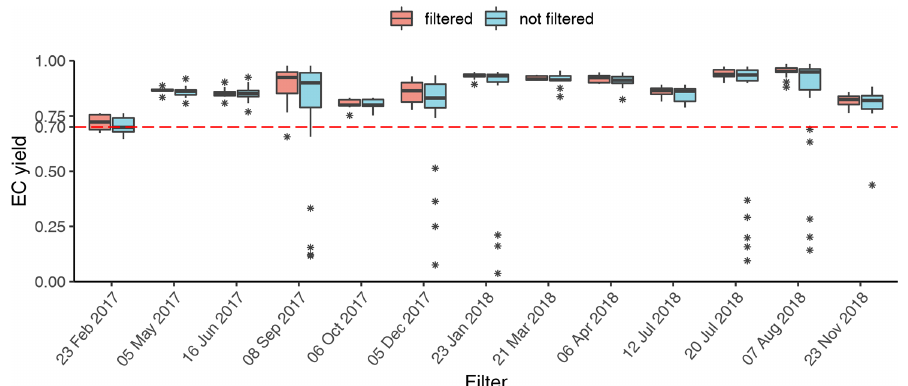
Figure 3. EC yield after WINSOC removal for each filter with the sampling start date. Filtered (WINSOC removal containing outliers in EC yield, fraction of charring S1, S2, or S3 removed) and unfiltered EC yields for each filter are shown. The boxplot box shows the first and third quartiles with the mean as a thick horizontal line for the individual groups (filtered and not filtered). The values outside the 1.5 interquartile range are shown with an asterisk. The horizontal line at 0.7 shows that at least 70% of the initial EC has been recovered.